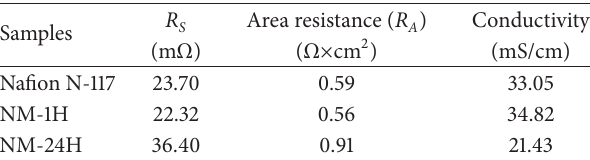
Table2:ComparisonofresistanceandconductivityforN-117aswell as modified